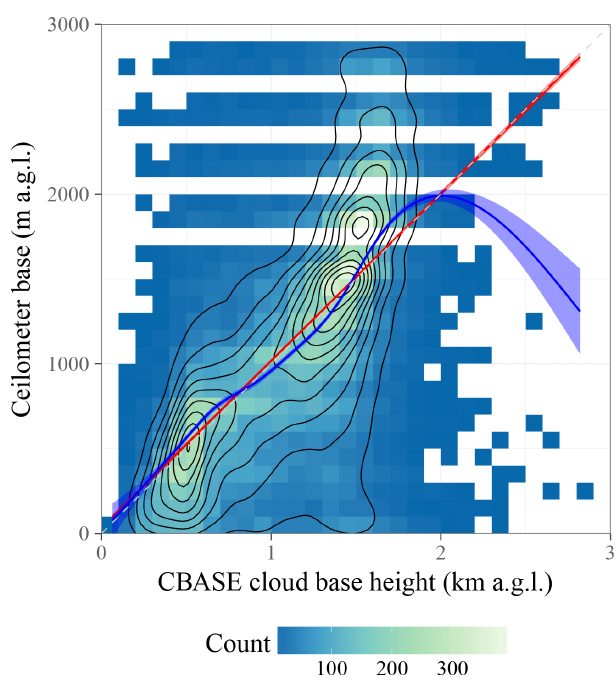
Figure 7. Scatter plot of CBASE versus ceilometer z for all A-Train overpasses over the contiguous US available for 2007; for descrip- tion of the plot elements, see Fig. 3. The linear fit has a slope of 0.98 and an intercept of 33 . 96m.